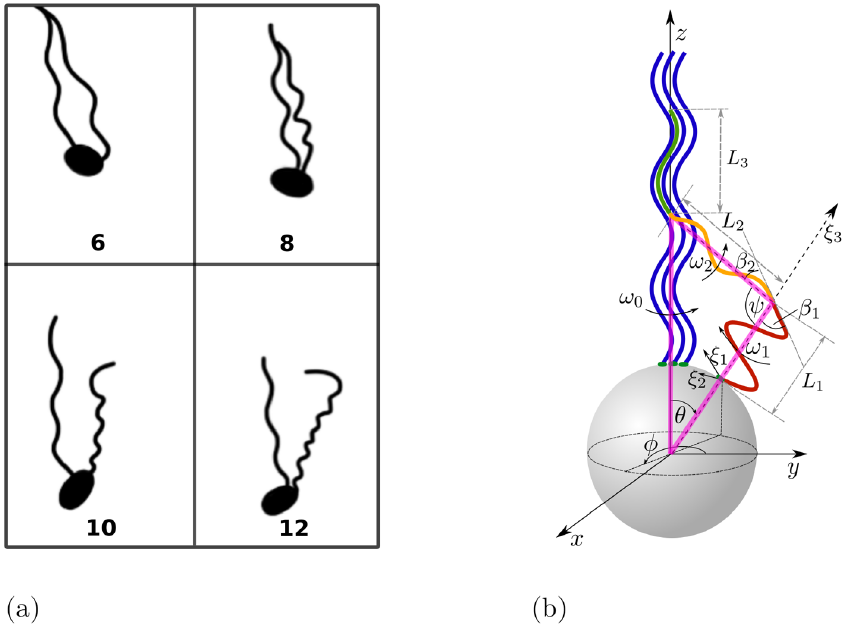
Fig 4. (a) Illustrations of a flagellar filament undergoing polymorphic transformation and unbundling based on fluorescent images reported in Fig 7 from Ref. [37]; numbers on the drawings correspond to different frames (the time between two consequent frames is 1/60 s). (b) Schematic representation of the unbundling process. The red part of the unbundling filament is in the semi-coiled form (near the cell body), while the orange (intermediate region) and green portions (distal part) have a normal shape. The bundle consists of the other three filaments shown in blue. Note that although the kinematic model assumes that the geometric transition between the normal and semi-coiled helices is smooth, the hydrodynamic model considers only purely helical